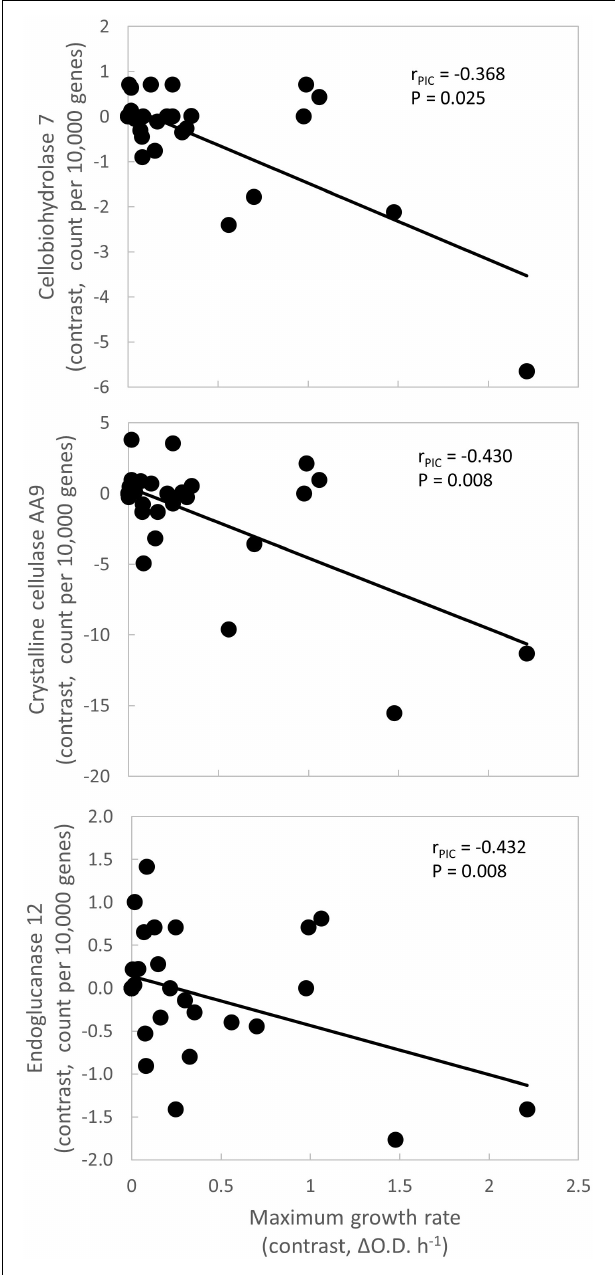
FIGURE 1 | Negative relationships between maximum growth rate and other traits. Each symbol represents an internal node within the phylogeny ( Supplementary Figure 1 ). Each node’s contrast value is the difference in average trait values between its daughter clades. This approach accounts for phylogenetic relatedness of taxa. Lines are best fit. P -values are unadjusted for multiple comparisons. Gene frequency data are from MycoCosm (Grigoriev et al., 2014). (cid:49) O.D. = Increase in optical density at 750